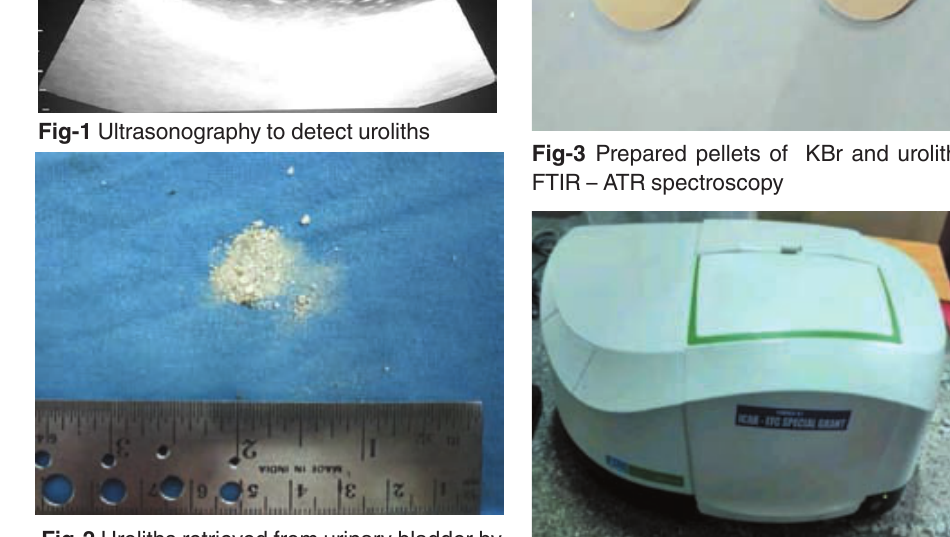
Fig-2 Uroliths retrieved from urinary bladder by tube cystostomy